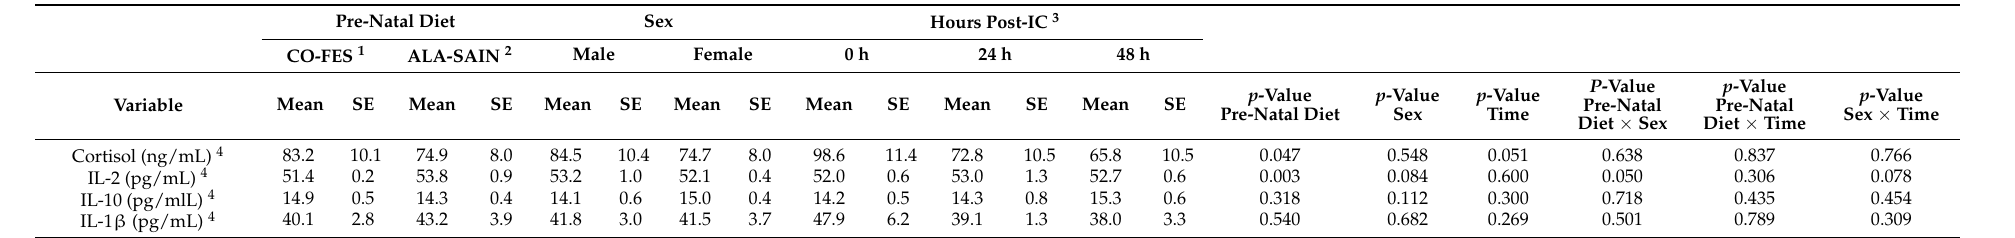
Table 7. Effects of pre-natal diet, lamb sex, time and their 2-way interactions on plasma cortisol and interleukin concentrations after the inflammatory challenge post AHP. Pre-Natal Diet Sex Hours Post-IC 3 CO-FES 1 ALA-SAIN 2 48 h